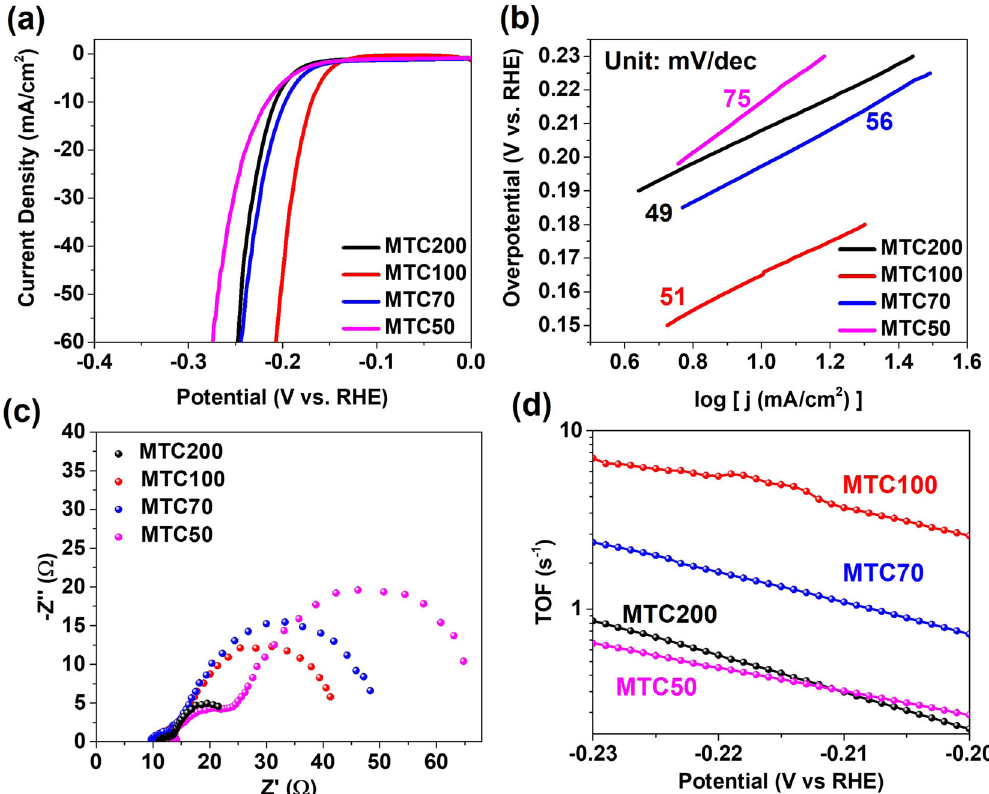
Fig. 6 The electrochemical results of MTC hybrids with different CNT ratios. a The polarization curves, b The Tafel plots, c The Nyquist plots, d The turnover frequency versus potential plots of MTC ternary composites with different CNT